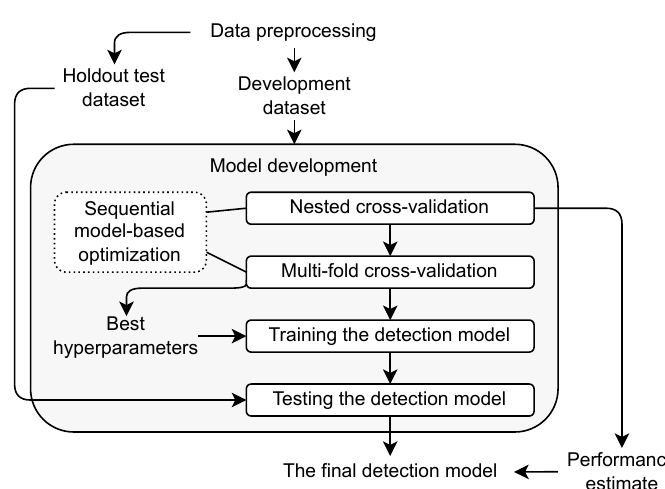
Figure 1. An overview of the model development